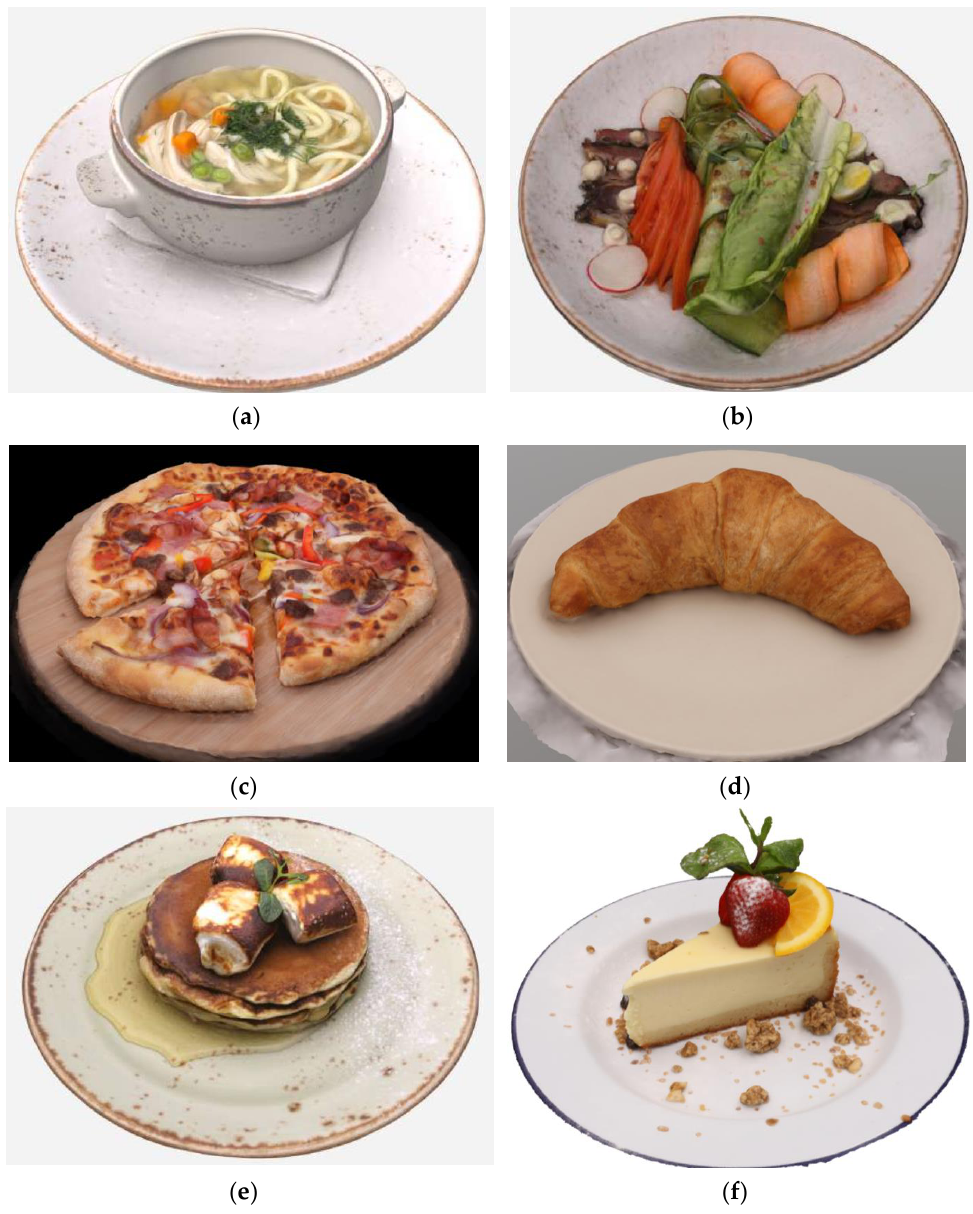
Figure 9. 3D models for AR subsistence need hunger experiences. Source: ( a , b , e ) [43], ( c , d , f ) [44].